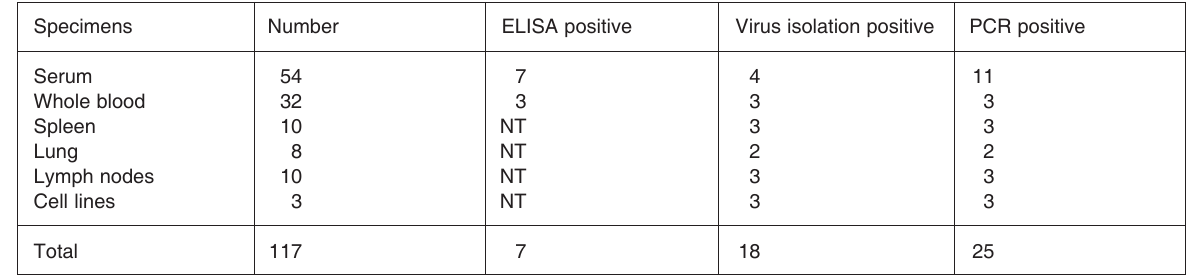
TABLE 1 BVDV isolates obtained by virus isolation, ELISA and confirmed with PCR Specimens